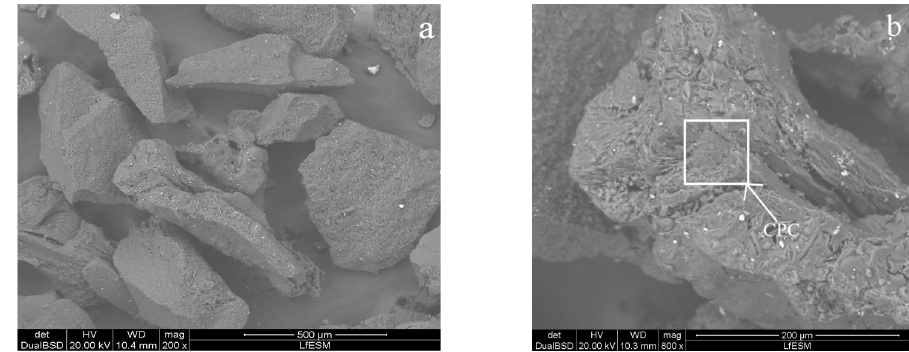
Figure 2. ( a ) SEM image of the calcined petroleum coke sample, magni fi cation 200×; ( b ) SEM image of the calcined petroleum coke sample with a spot of the EDS spectrum (CPC), magni fi cation 800×.